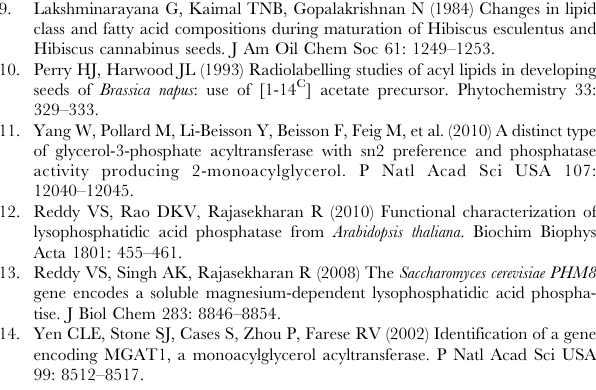
Figure S2 Nile Blue lipid staining of N.